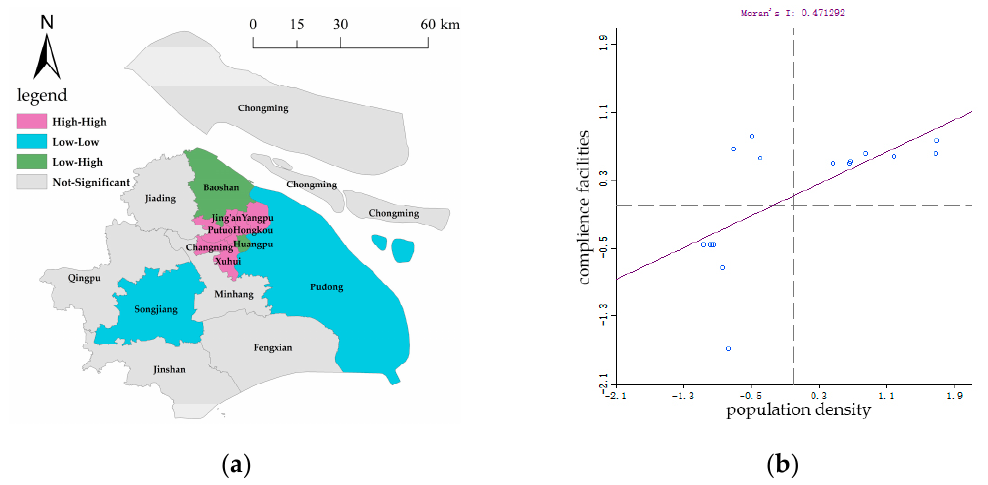
Figure 5. Local spatial patterns (Bivariate local Moran’s I) between population density and the over ‐ all level of walkability of the 15 ‐ min walkable neighborhoods in 16 districts. ( a ) LISA Cluster Map; ( b ) Moran Scatter Plot.